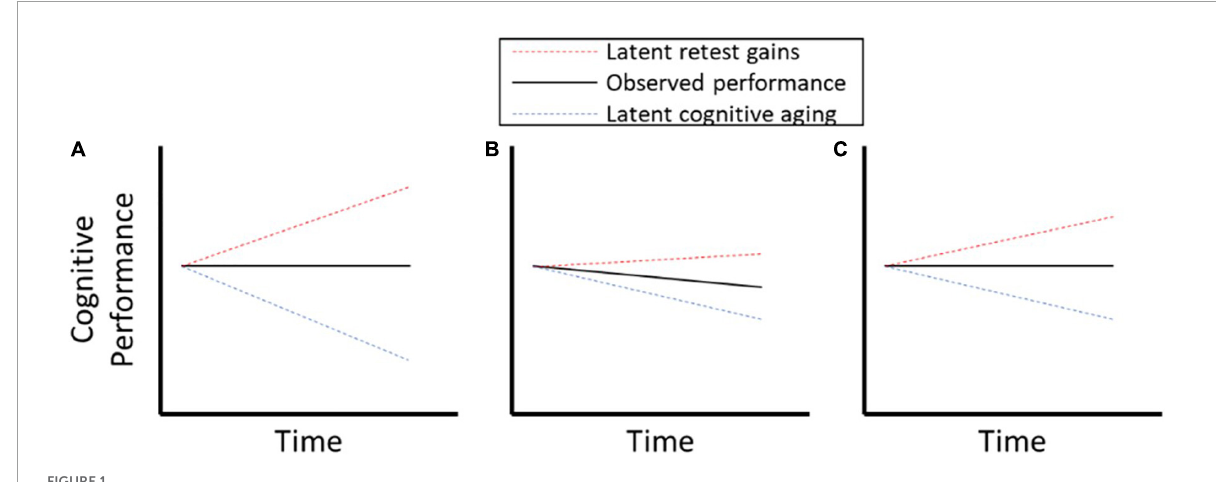
FIGURE1 (A–C) Illustration of retest effects confounding measurement of cognitive